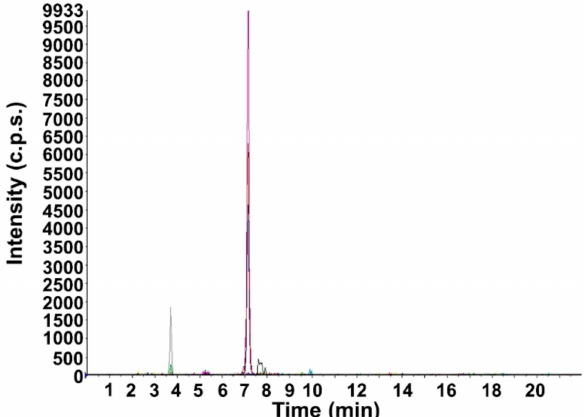
Figure 3. MRM chromatogram of Cyclamen freeze-dried